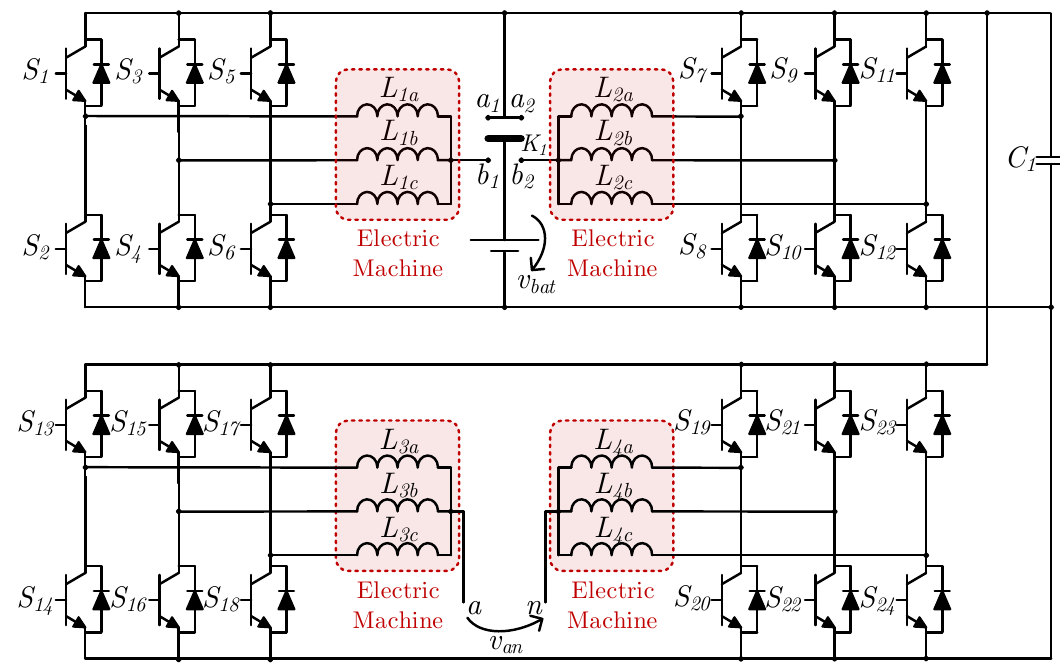
Figure 15. EV IBC proposed by S. K. Sul and S. J. Lee in 1995 [32].